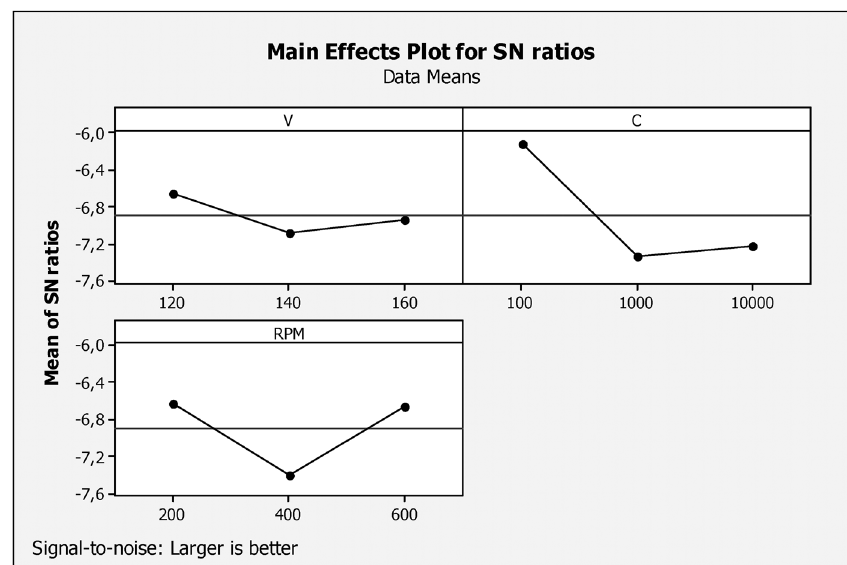
Figure 7: Analysis of S / N of Deng ’